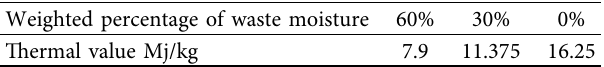
Table 3: Thermal value of waste for waste incineration in terms of waste moisture content.